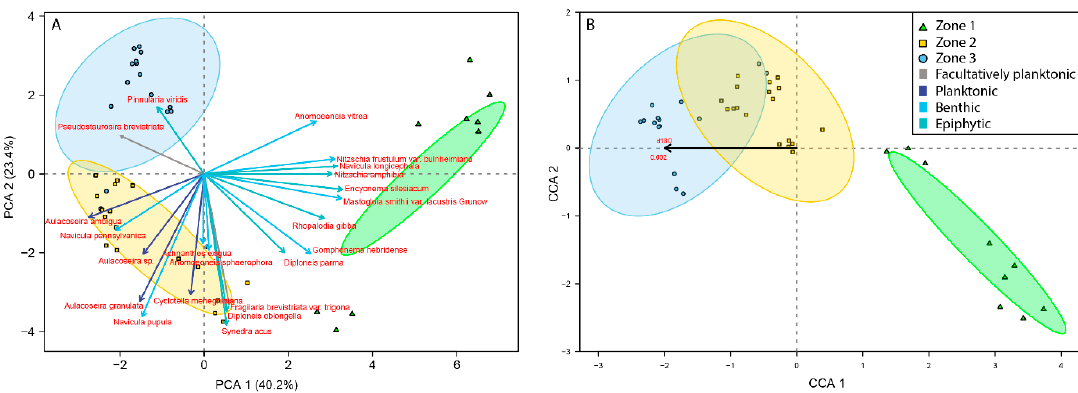
Figure 5. Principal component analysis of the diatom assemblage ( A ) Canonical correspondence analysis of the diatom assemblage ( B ) Zones derived from the broken stick model conducted on the palynological assemblage represented by ellipses at a confidence of 95%. Zone 1 = green triangles; Zone 2 = yellow squares; Zone 3 = blue circles.